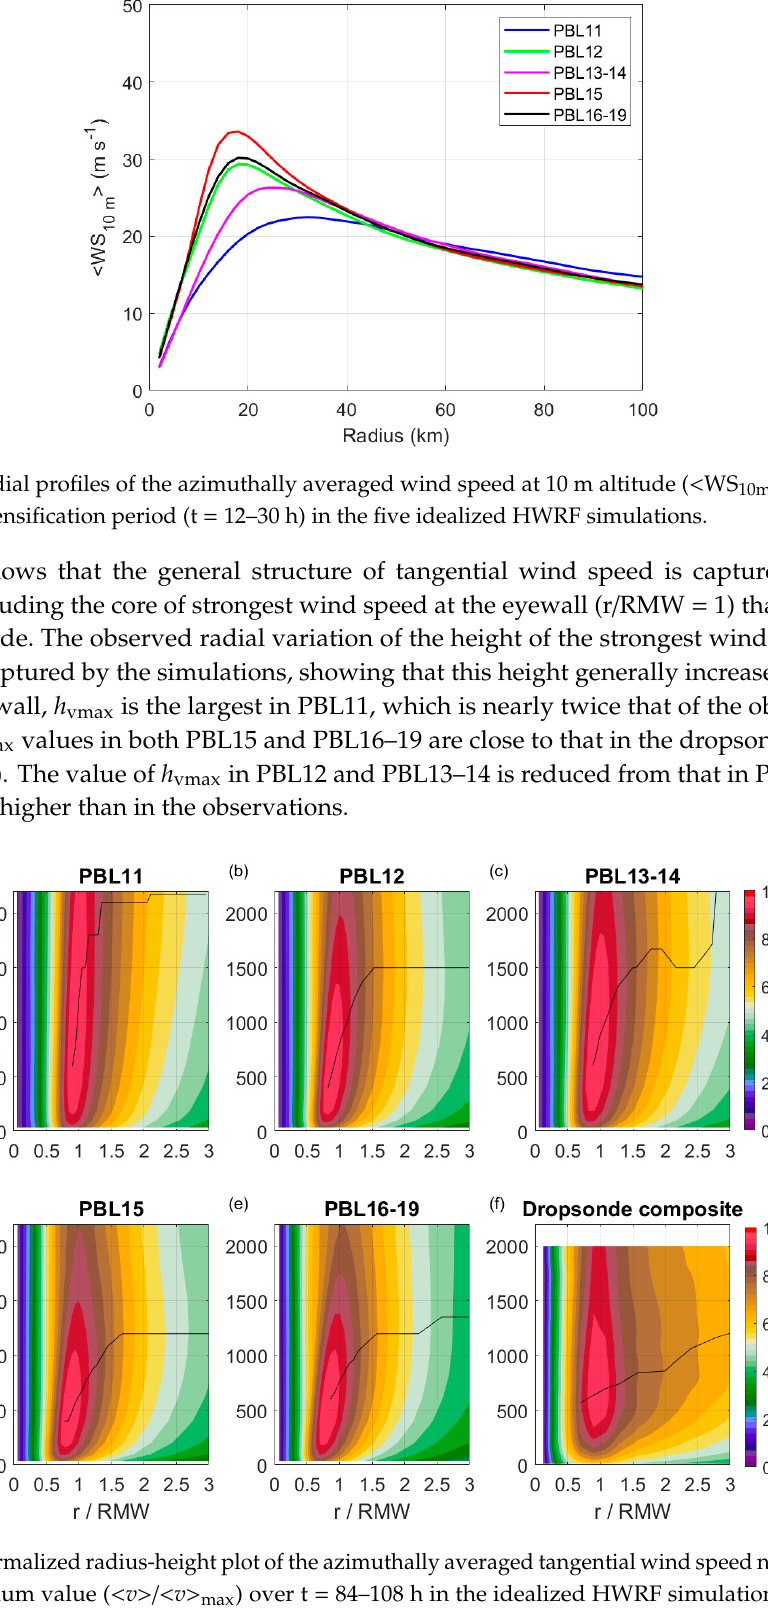
Figure 6. Normalized radius ‐ height plot of the azimuthally averaged radial wind speed normalized by the peak inflow strength (< u >/|< u > min |) over t = 84–108 h in the idealized HWRF simulations with ( a ) PBL11, ( b ) PBL12, ( c ) PBL13 ‐ 14, ( d ) PBL15, and ( e ) PBL16 ‐ 19 schemes. The dropsonde composite of < u >/|< u > min | is shown in ( f ). The black line denotes the inflow layer depth. RMW is the radius of the maximum wind speed. Negative value of u represents inflow.